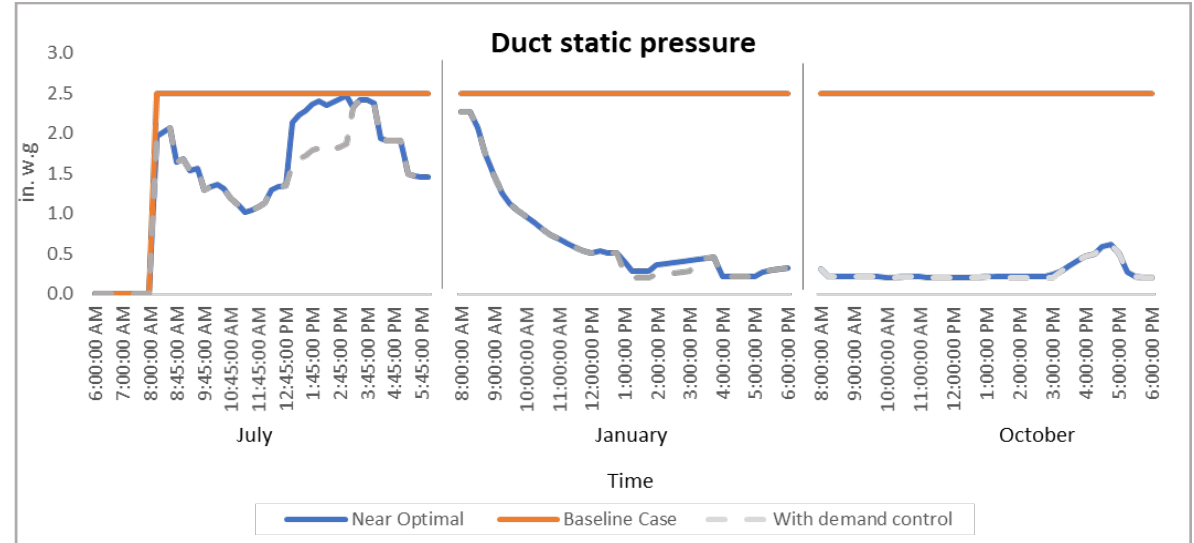
Figure 11. The five zones duct static pressure for each day being analyzed.